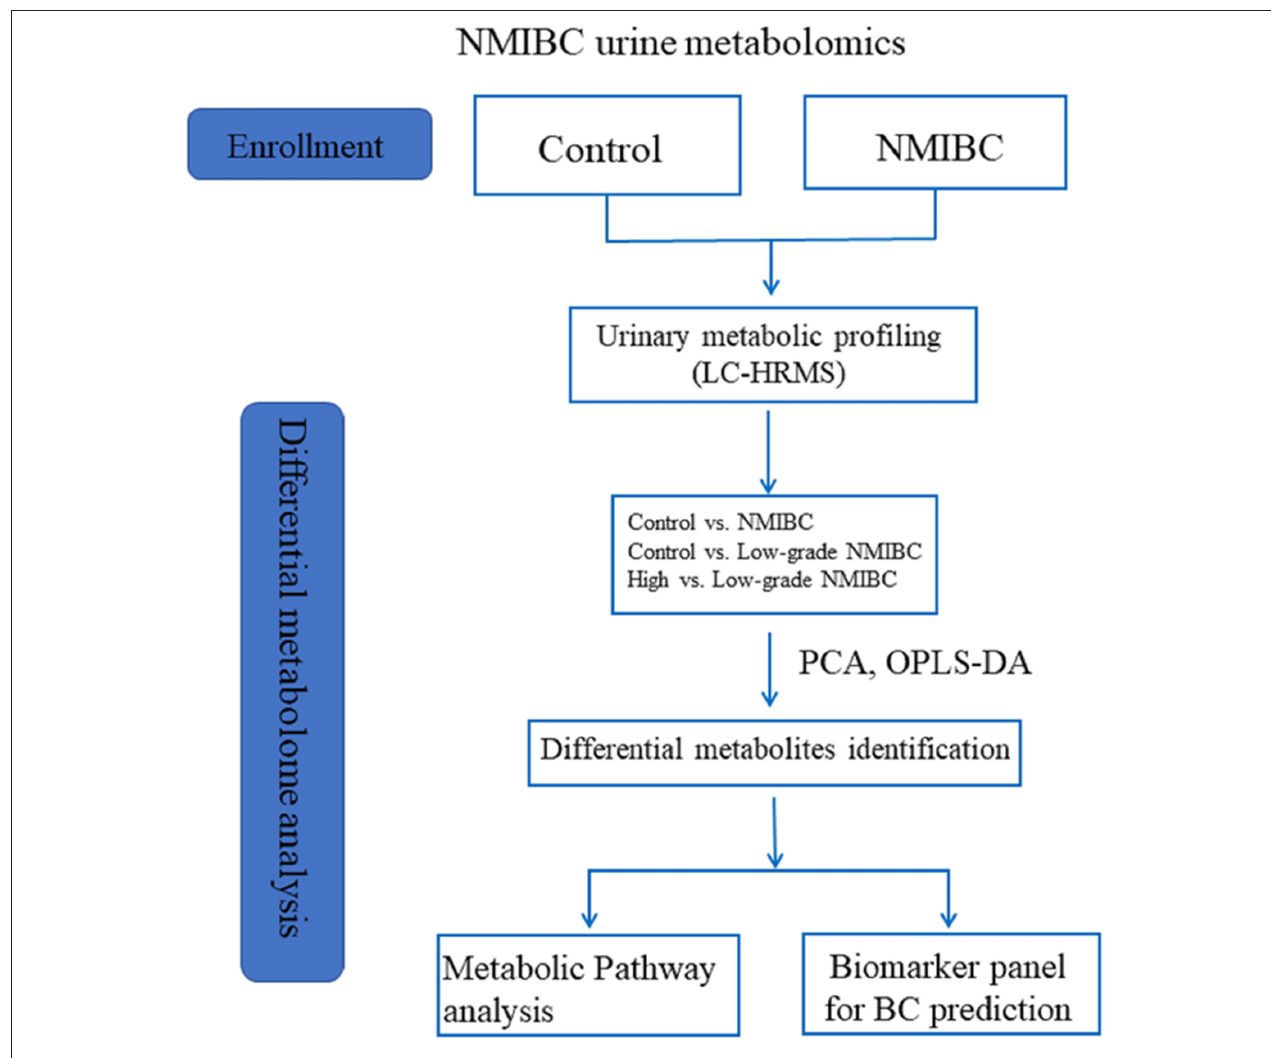
FIGURE 1 | The workflow of this